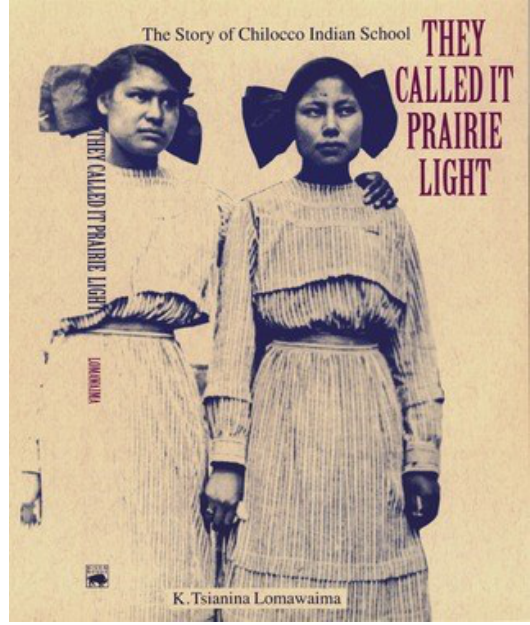
Figure 18. Book cover for They Called It Prairie Light by K. Tsianina Lomawaima.